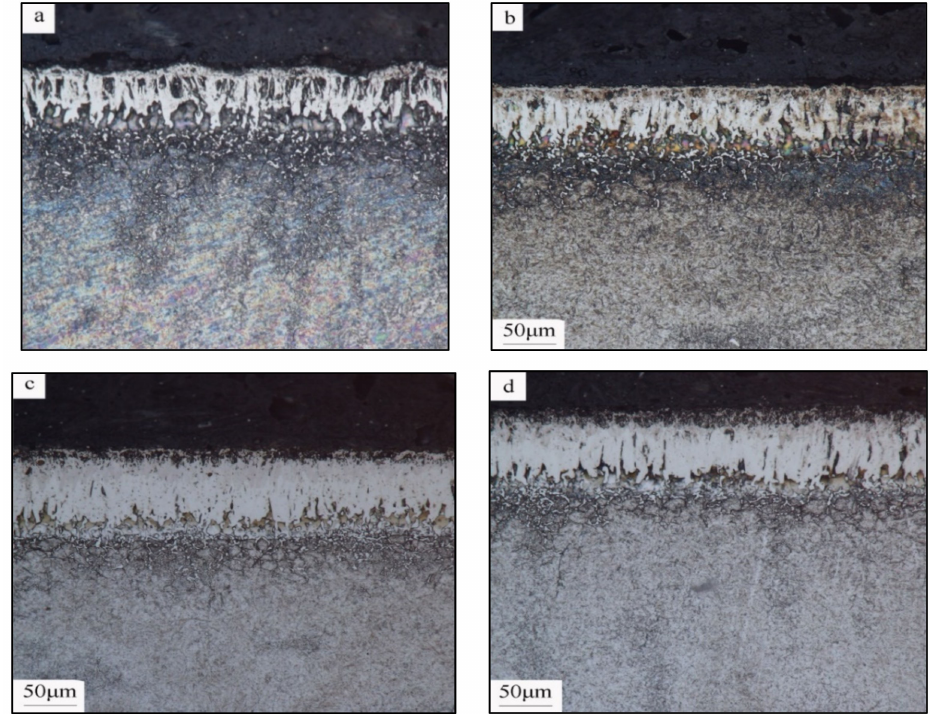
Figure 5. Microstructure of boronizing layer at different boronizing temperatures (boronizing